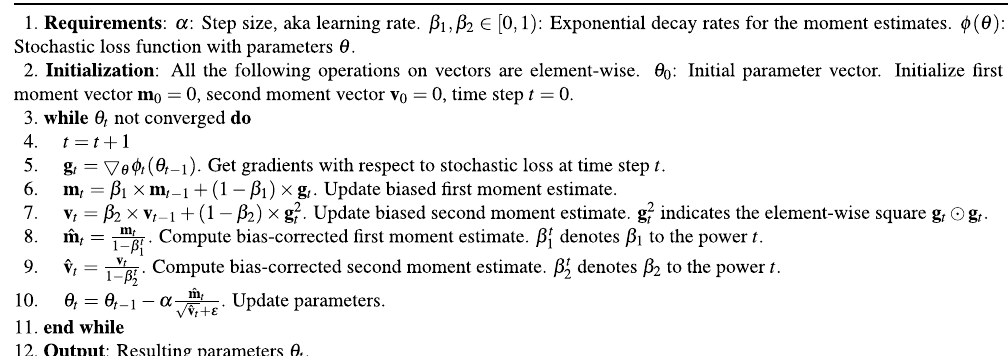
Algorithm 1. Adam, employed optimization algorithm for stochastic loss